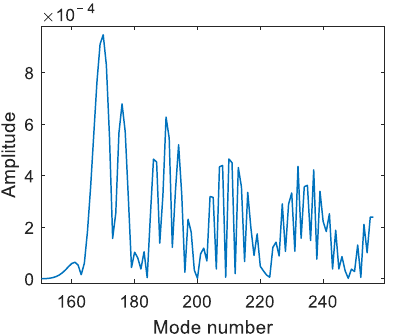
Figure 3. Transmission losses in range-independent and range-dependent environments for linearly varying sound speed. To calculate the position of the convergence zone in a range-dependent environment with linear variation in sound speed according to Equation (20), the modal strength of the normal modes of each order must be calculated. The corresponding results are shown in Figure 4. The modal strength of the lower mode is 0, and only the part with the larger amplitude is shown in the figure.